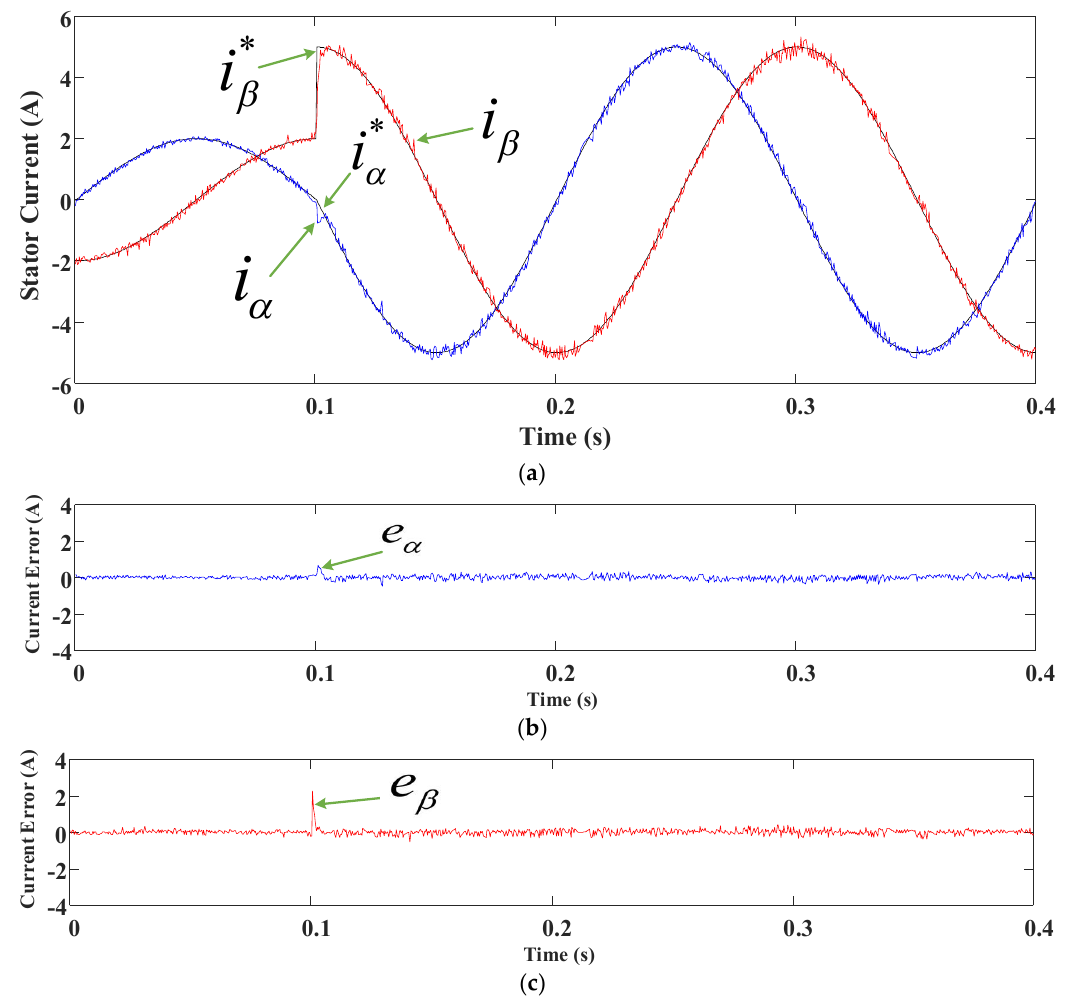
Figure 19. Experimental results of DVV-MFPCC following a sinusoidal current command with amplitude jumping from 2 A to 5 A at 0.1 s under frequency 10 Hz (case 3): ( a ) current responses; ( b ) α -axis current error; ( c ) β -axis current error.